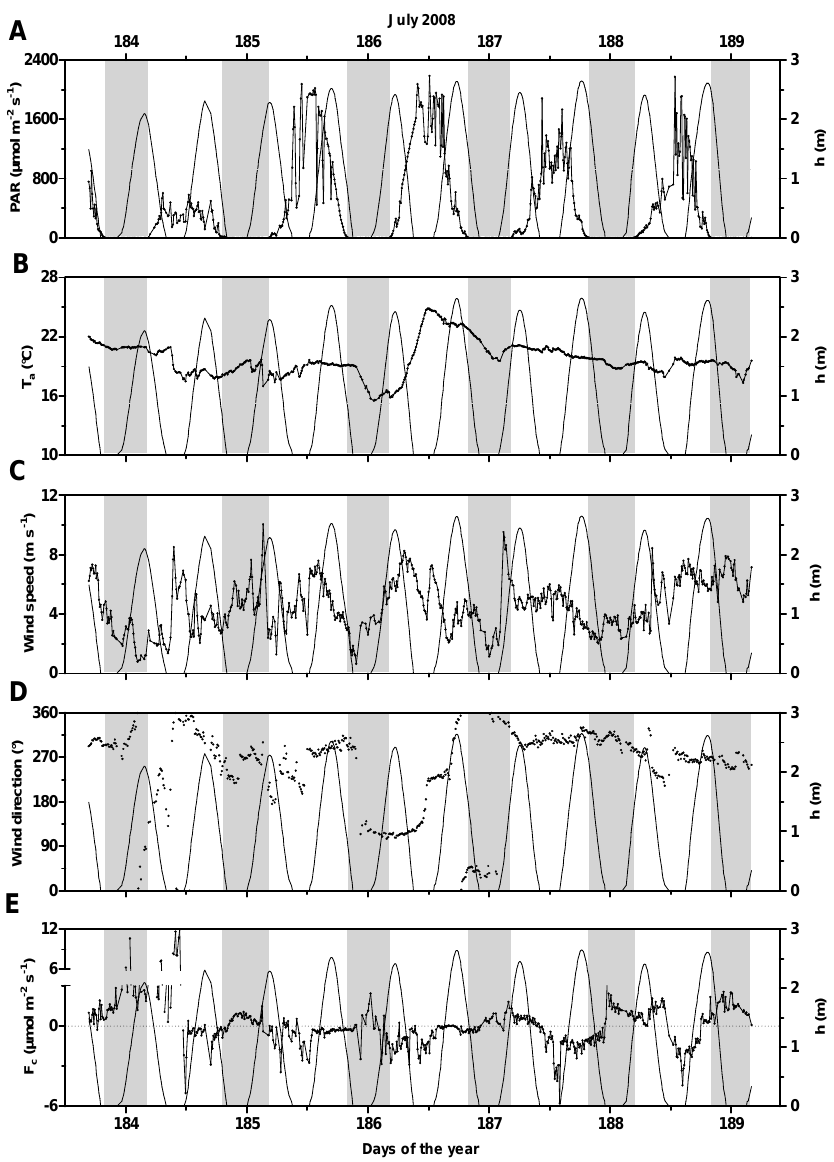
Fig. 4. Environmental parameters and carbon dioxide fluxes measured during the EC deployment in the Arcachon flat (St. 1) from 1 July at 16:40 to 7 July 2008 at 04:00 (GMT). (A) Photosynthetically active radiation PAR (µmolm − 2 s − 1 ) and water height (m); (B) temperature of the air ( ◦ C); (C) wind speed (ms − 1 ) ; (D) wind direction ( ◦ ) and (E) carbon dioxide fluxes (µmolm − 2 s − 1 ) . Negative fluxes represent sinks of CO 2 , and positive fluxes represent sources of CO 2 to the atmosphere by convention. Day 183 squares with 1 July 2008 and grey bands represent night periods. A PAR threshold of 20µmolm − 2 s − 1 was chosen to separate day and night cases, and low tide cases correspond to zero-water heights. A specific range for F c (E) was chosen for a better visualisation of CO 2 flux